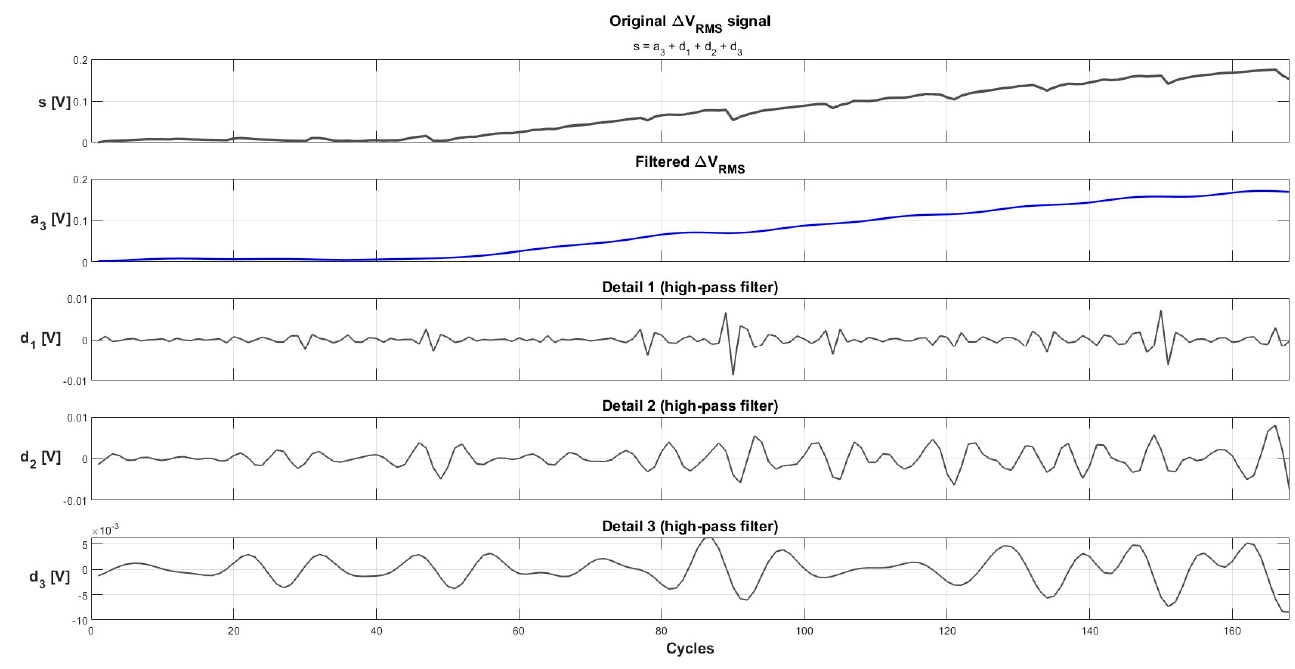
Figure 5. DWT filter applied to the computed values of ∆ V RMS . The figure shows the original Figure 5. DWT fi lter applied to the computed values of Δ V RMS . The fi gure shows the original sig- signal, its approximation or filtered signal, and the three details removed from the original signal, nal, its approximation or fi ltered signal, and the three details removed from the original signal, corresponding to successive high-pass corresponding to successive high-pass fi lters.